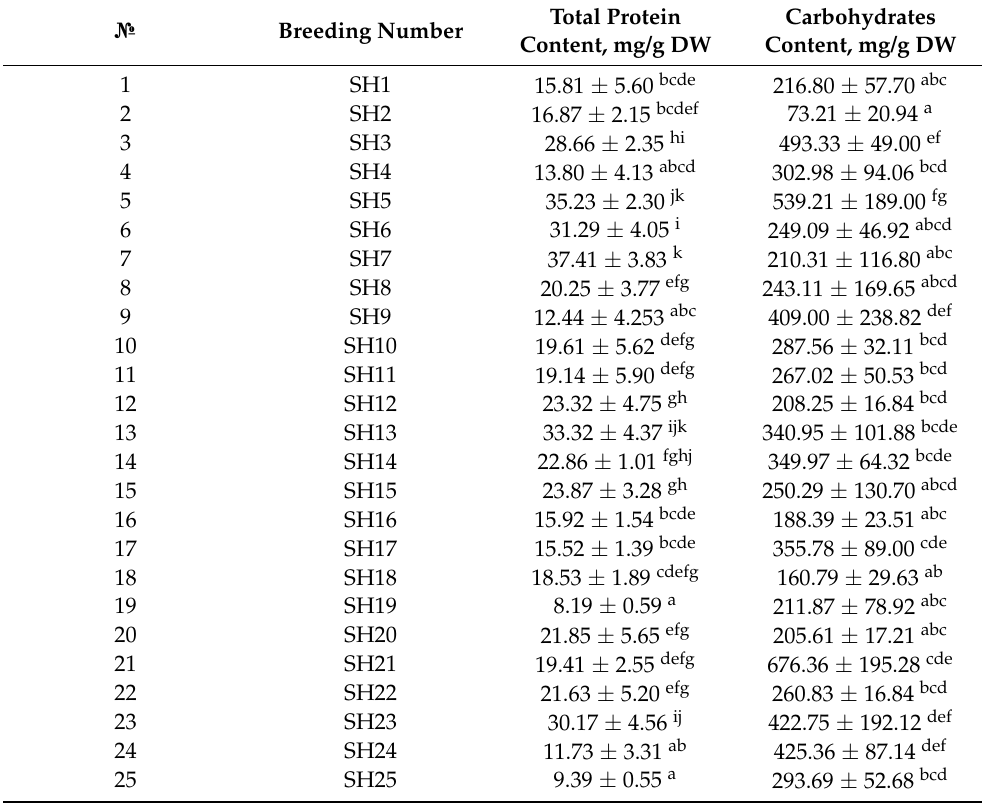
Data represent the mean of three replicates ± confidence interval. Results were analyzed by 2-way ANOVA. Means were subjected to Duncan post hoc test ( p < 0.05). Different letters in the same column indicate significant differences according to post hoc test